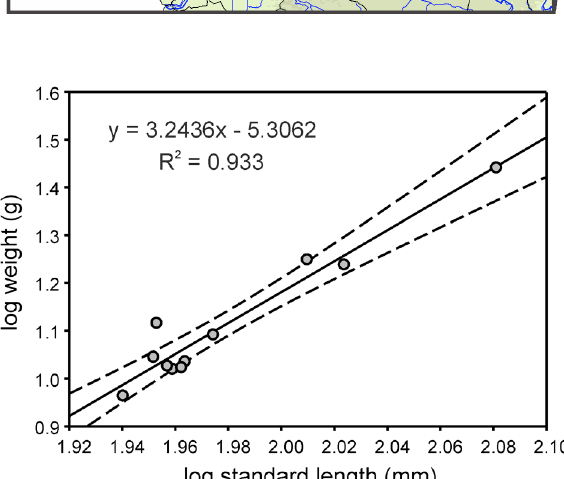
Figure 4. Distribution of Glyptothorax poonaensis .